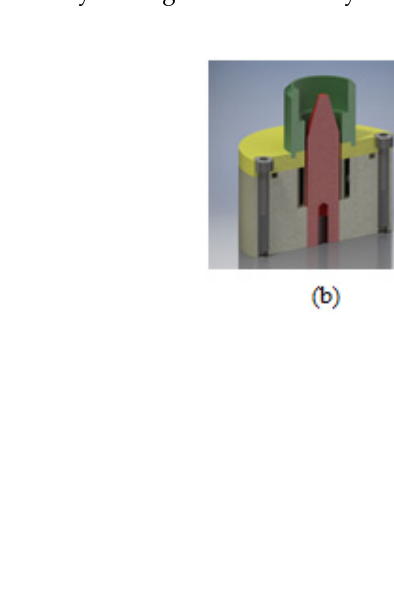
Figure 11. Scheme of the experimental setup.